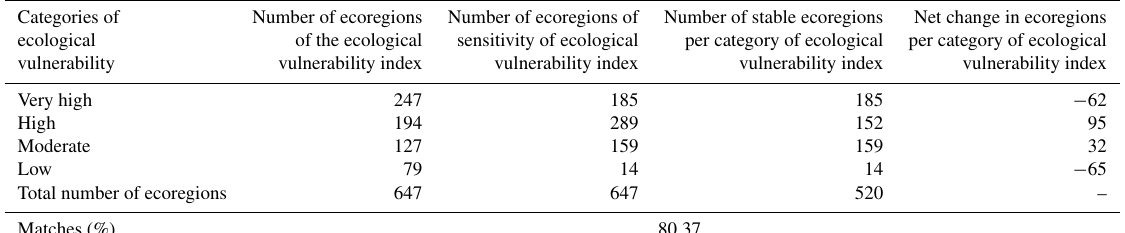
Table 12. Accuracy of the model, number of ecoregions per category of ecological vulnerability to fire from the index and sensitivity method, and number of and net change in number of stable ecoregions between the index and sensitivity